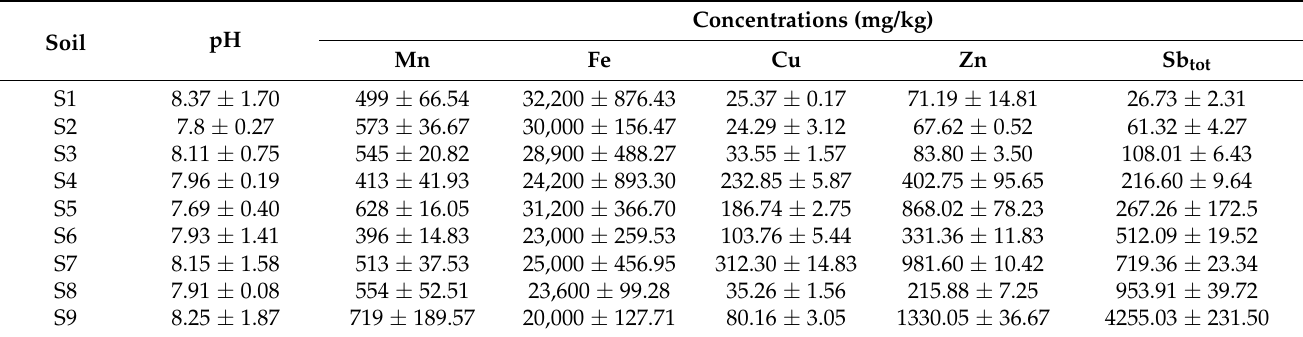
Table 1. Main physicochemical characteristics of soils.